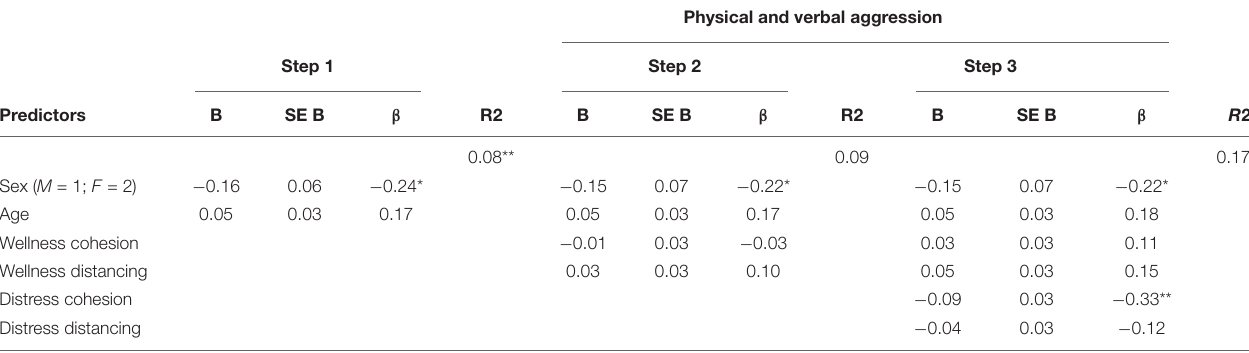
TABLE 2 | Summary of hierarchical regressions predicting physical and verbal aggression from drawing